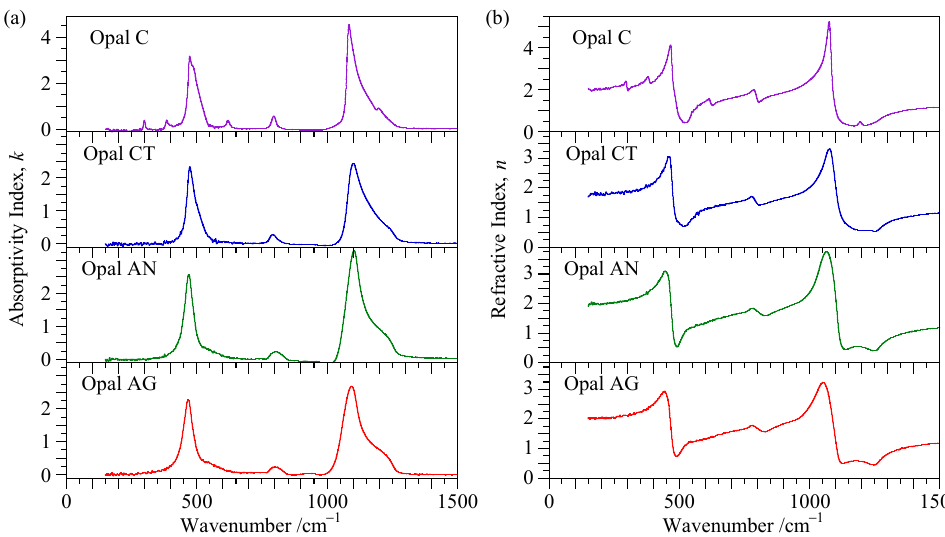
Figure 6. Kramers-Kronig-transformed spectra of polished slabs of (red) opal-AG (CP-2 from Coober Pedy, South Australia, Australia), (green) opal-AN (MS-1 from Mount Squaretop, Queensland, Australia), (blue) opal-CT (G9942 from Angaston, South Australia, Australia) and (violet) opal-C (T1664 from Guanajuanto, Mexico)); ( a ) the absorptivity index, k , and ( b ) the refractive index, n . Table 4. Absorptivity index peak positions derived from the Kramers-Kronig transform of the 15° incidence angle reflec- tion measurements for the samples shown in Figure 6.